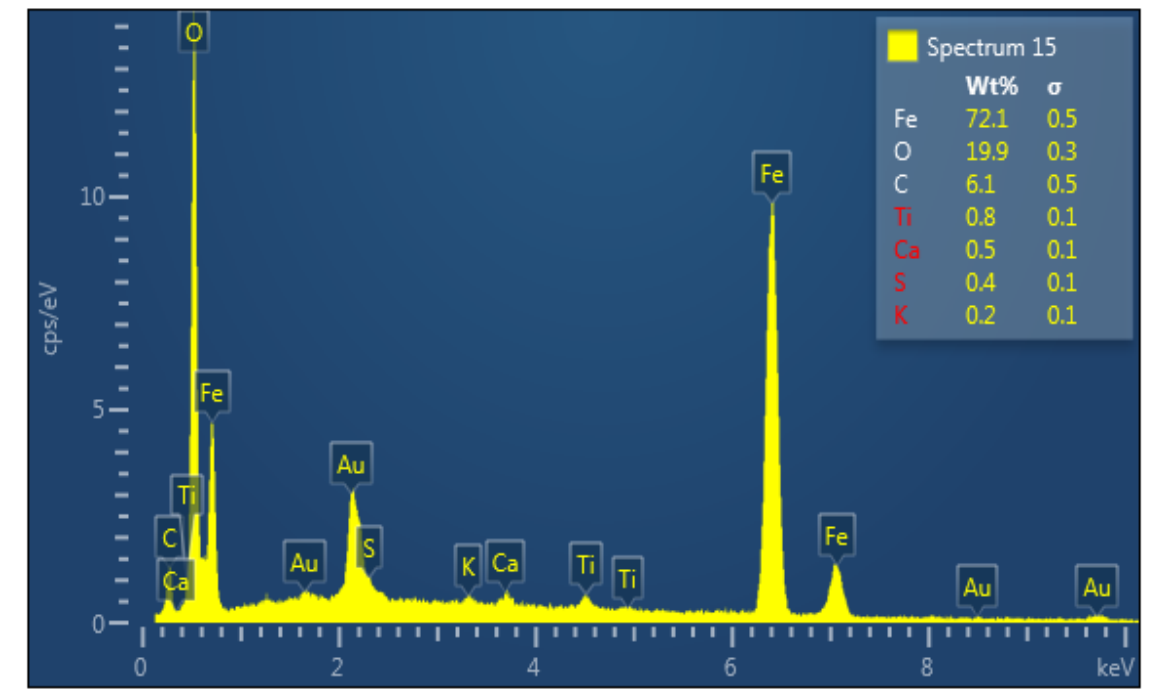
Figure 5. EDX of the Fe 3 O 4 NPs/CA.